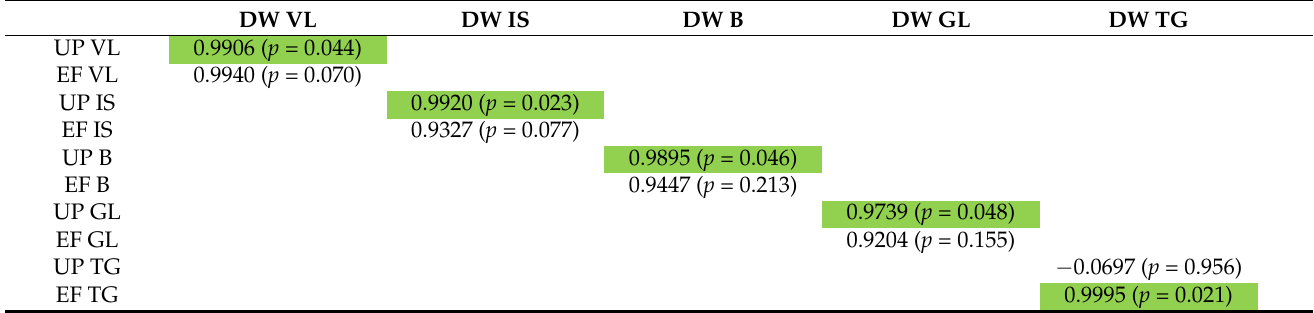
Table 2. Spearman correlation coefficients of biocide compounds in the aquatic